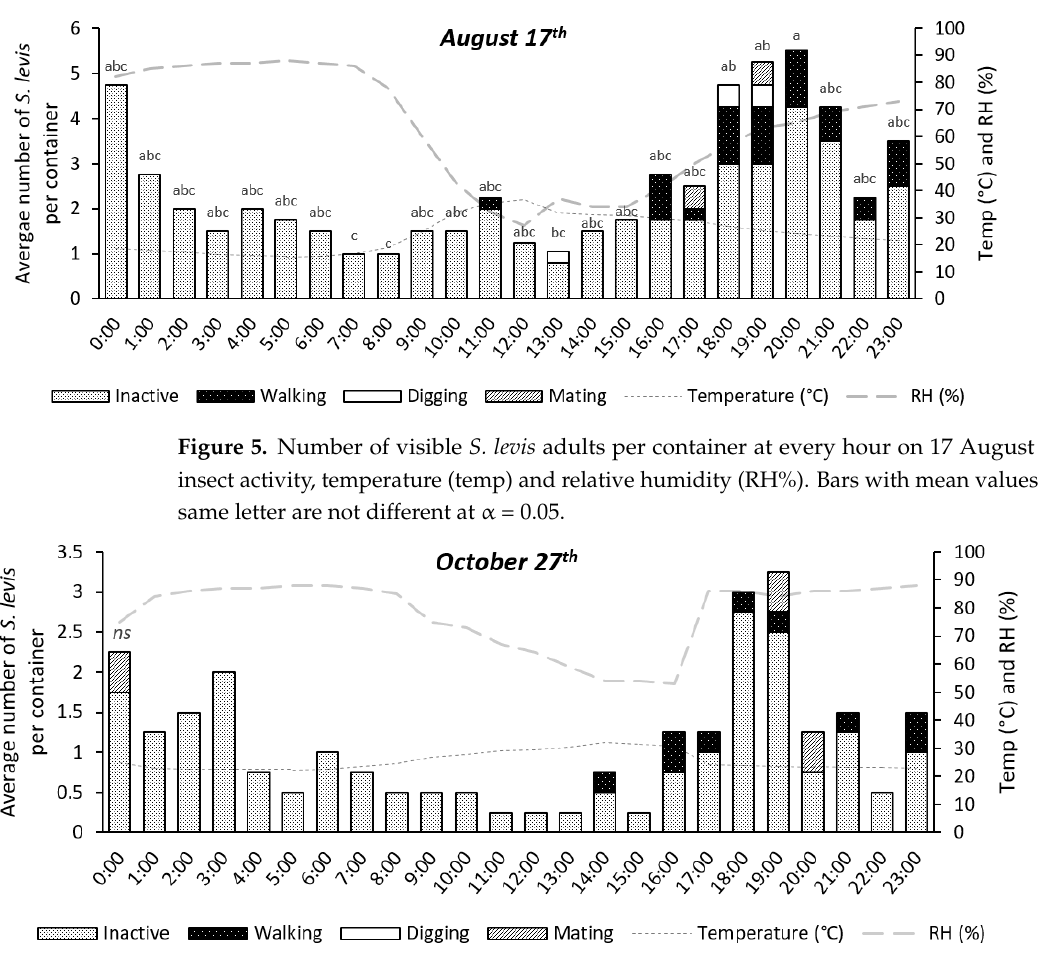
Figure 6. Number of visible S. levis adults per container at every hour on 27 October considering insect activity, temperature (temp) and relative humidity (RH%). ns —no significant differences were observed at α = 0.05.